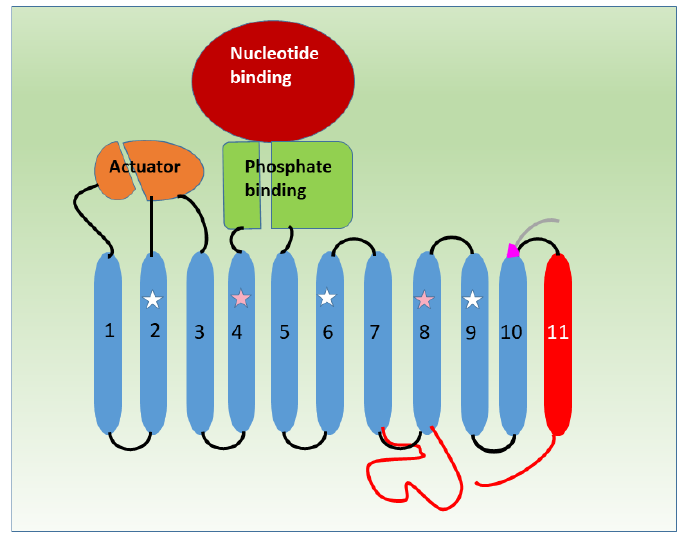
Figure 1. Unified topology diagram of SERCA1a, SERCA1b, SERCA2a and SERCA2b based on [12]. The conserved TM1-10 is blue. C-terminal glycine of SERCA1a is purple, the tail of SERCA1b is grey. TM7-TM8 intraluminal loop, TM11 and the intraluminal tail of SERCA2b are red. Actuator (orange), nucleotide binding (dark red), phosphate binding (green). White stars indicate TMs that may interact with small membrane peptides called regulins and pink stars those that bind Ca 2+ in functional conformations [9]. The parts of the diagram are not always proportional to the length of the illustrated sequence. A time-scaled animation of the activity cycle using a SERCA ortholog P-type ATP-ase [13] is available at: https://www.youtube.com/shorts/3AuGFrfNfJ8 accessed